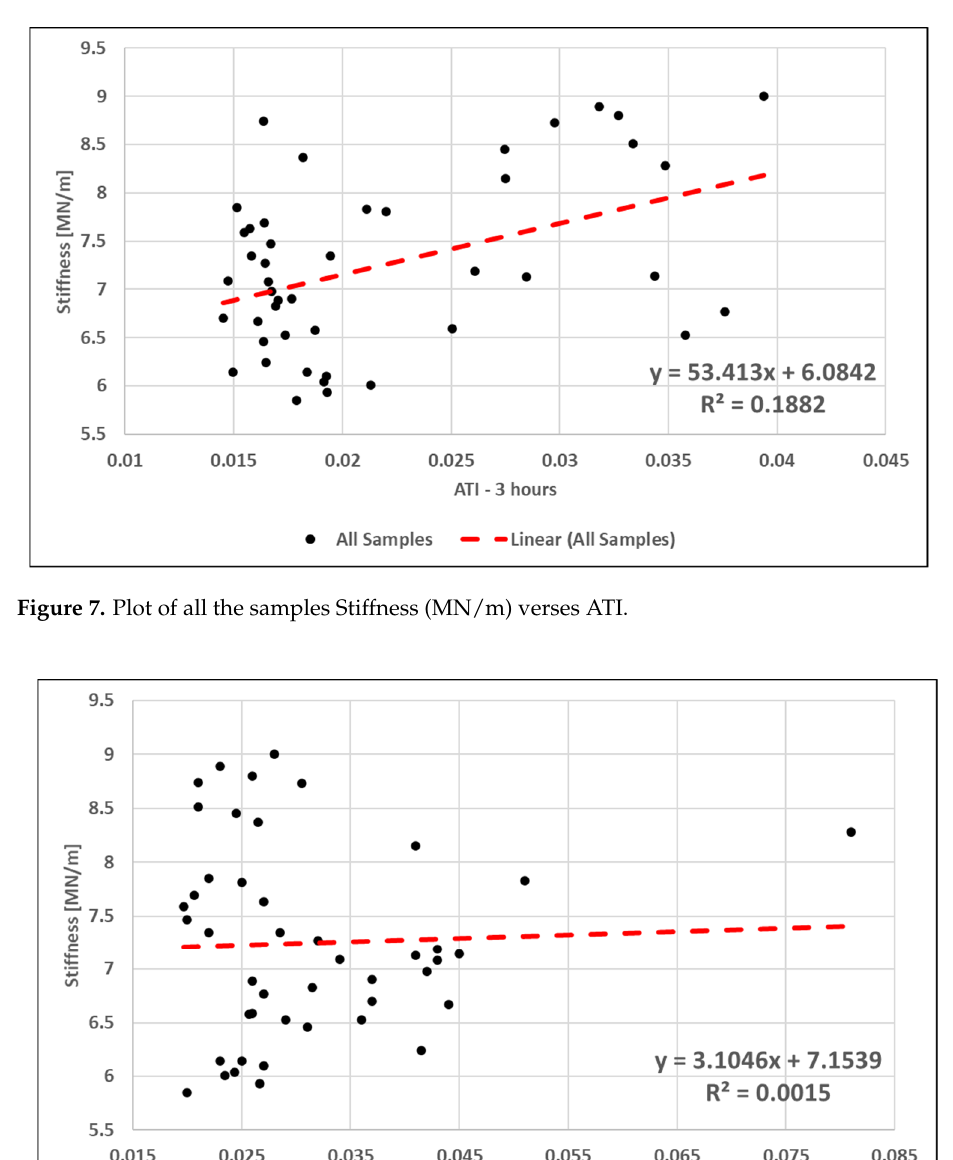
Figure 6. Box plot of the soil stiffness values [MN/m] for each of the individual soil types from all laboratory trials.